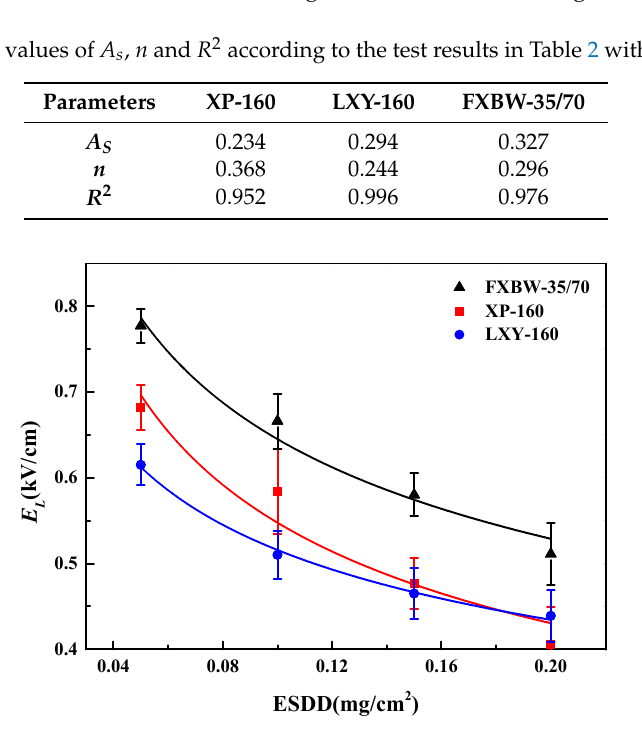
Figure 6. Relationship between E L and ESDD .